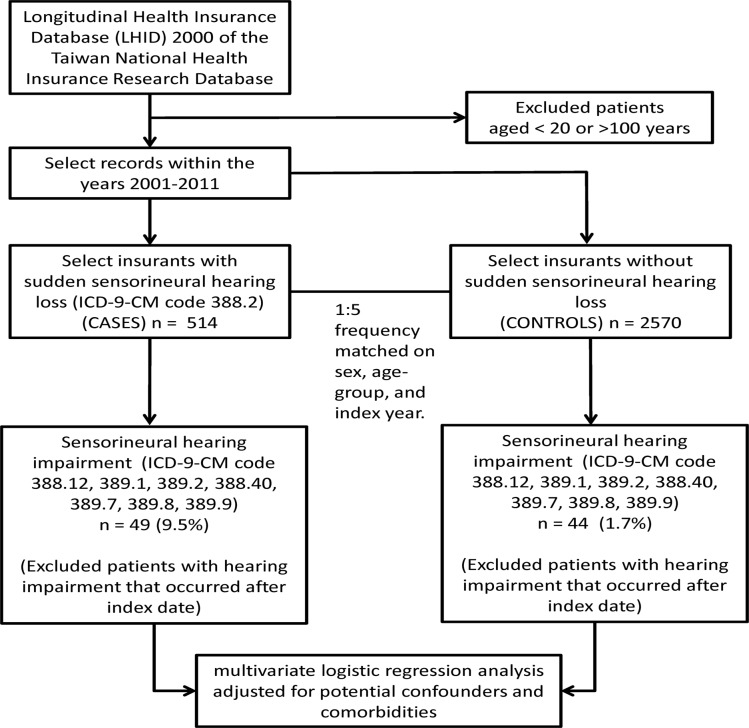
Flow diagram of the study.
ICD-9-CM. International Classification of Diseases, Ninth Revision, Clinical Modification.